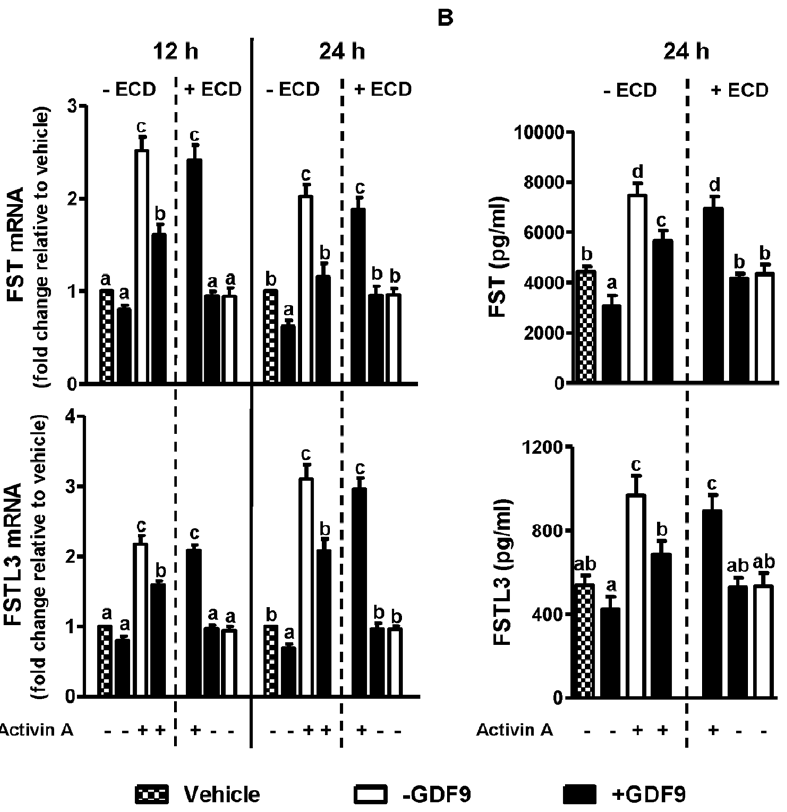
Figure 2. GDF9 reversed activin A-induced FST and FSTL3 expression, effects attenuated by BMPR2 ECD. After 48 h preculture, hGL cells were incubated in low-serum media (0.5% FBS) with and without 100 ng/ml of GDF9 for another 24 h before stimulation with 25 ng/ml of activin A for 12 h (‘‘Time 12 h’’) and 24 h (‘‘Time 24 h’’). The neutralization experiments with BMPR2 ECD (‘‘ECD’’) and GDF9 were as described in Figure 1. FST and FSTL3 mRNA levels (A) in hGL cells and protein concentrations (B) in culture media were assessed by real-time PCR and ELISA, respectively. Results were the means 6 SEM from at least four sets of experiments (each from a separate patient), and in each set, measurements were made in triplicate for real-time PCR or duplicate for ELISA. At each time point, means without a common letter are significantly different ( P , 0.05).